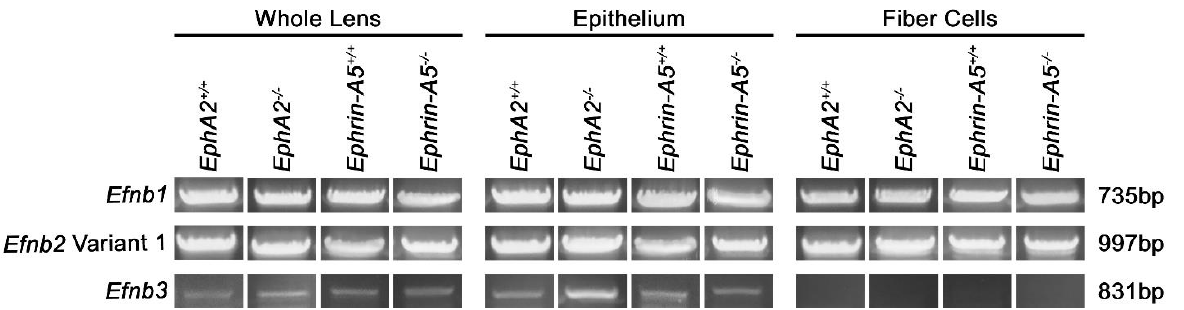
Figure 4. Efnb transcripts, which encode for ephrin-B proteins, in whole lens, lens epithelial cell, or lens fiber cell RNA samples from 6-week-old EphA2 +/+ , EphA2 − / − , ephrin-A5 +/+ , and ephrin-A5 − / − mice. We detected Efnb1 and Efnb2 variant 1 in the lens. Efnb3 was detected in the whole lens and epithelial cells, but not detected in fiber cells.